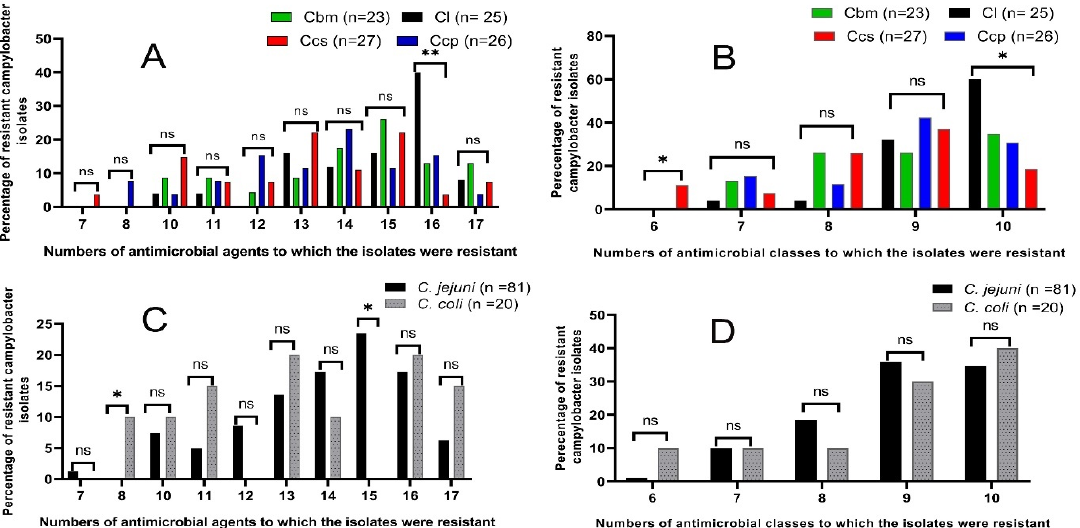
Figure 2. Antimicrobial resistance patterns of the total campylobacter isolates from different chicken sources ( A , B ) and C. jejuni and C. coli ( C , D ). Cl: chicken liver; Cbm: chicken breast meats; Ccp: